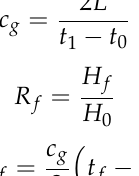
Figure 6. Time history and envelope of UGWs with central frequency of 60 kHz propagating in threaded rod.